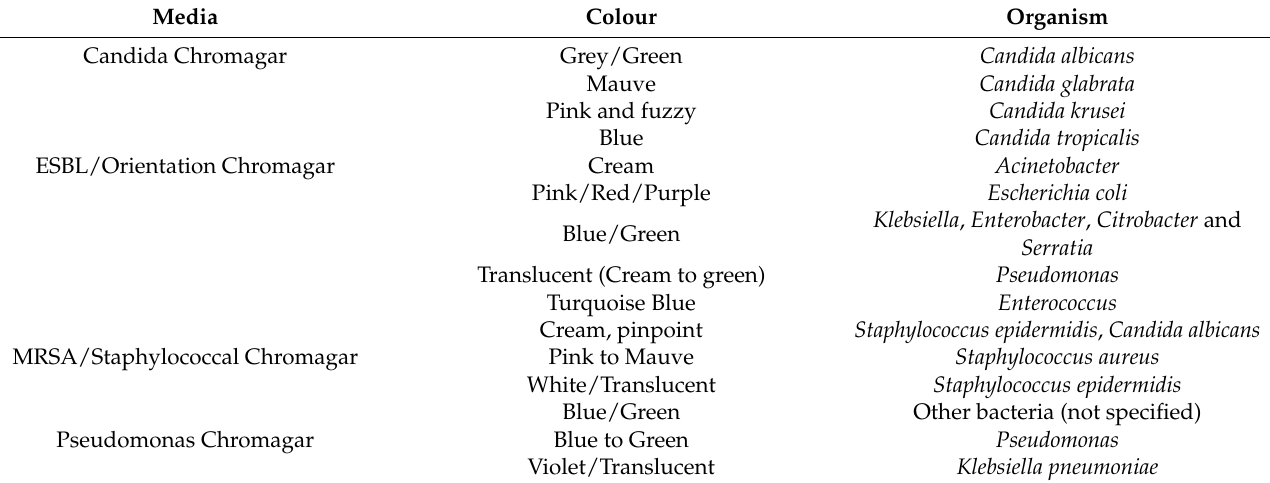
Table 2. Colour of Chromagar for